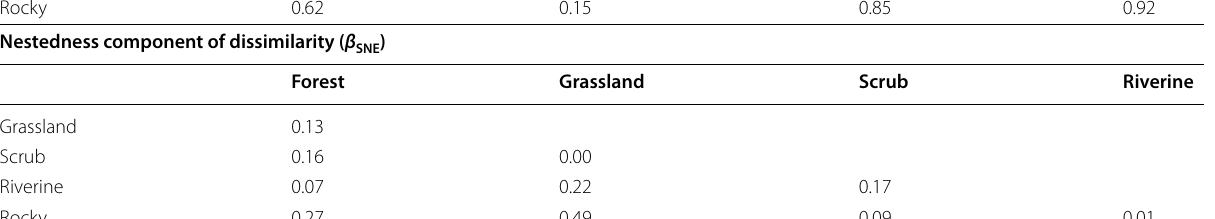
Table 2 Pair-wise Sorenson dissimilarity ( β Sorenson dissimilarity ( β SOR )